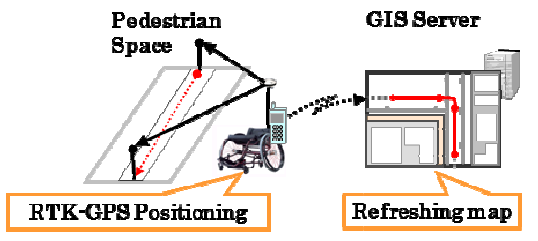
Figure 1. Concept of “Real Time GIS”